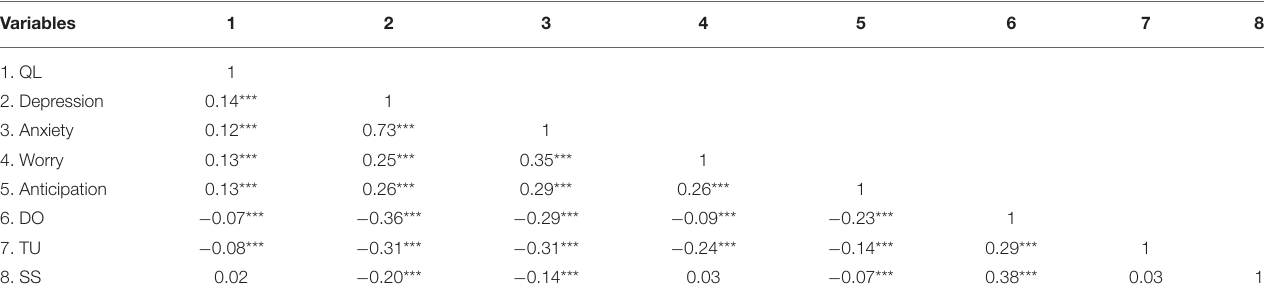
TABLE 2 | Intercorrelations between all study measures.